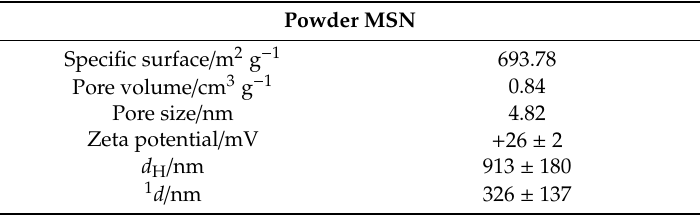
Table 1. The porosity, morphology and stability of MSNs in powder and dispersed in water.